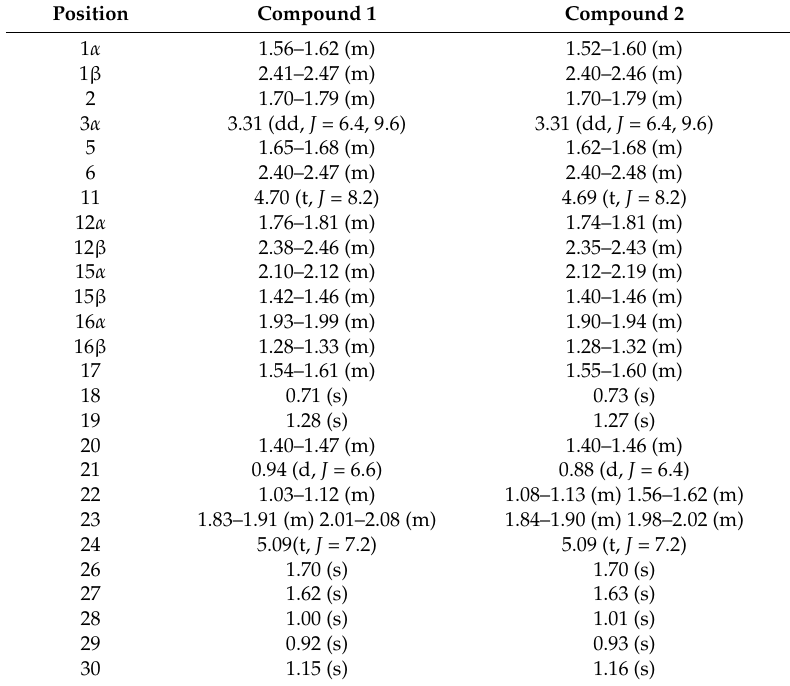
Table 1. 1 H-NMR data for compounds 1 and 2 .